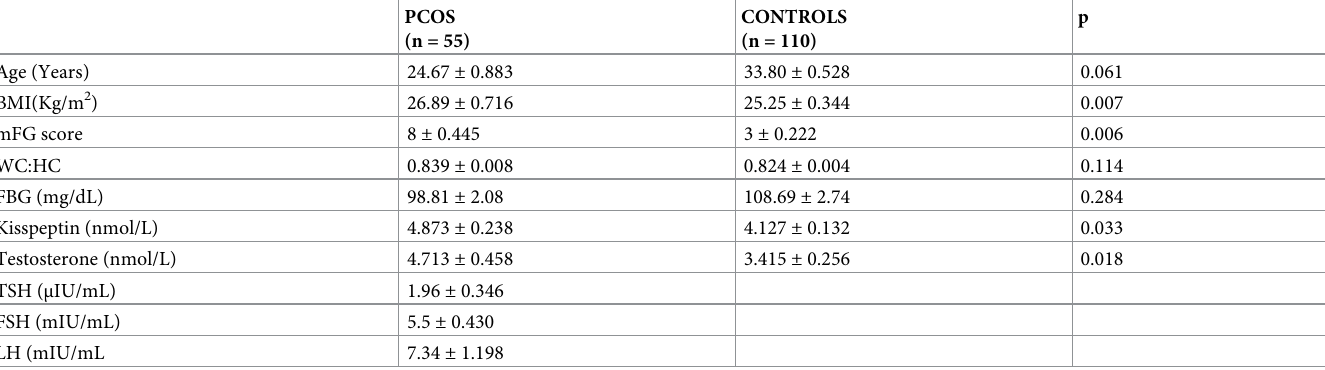
Table 2. Demographic, clinical and biochemical characteristics of the study